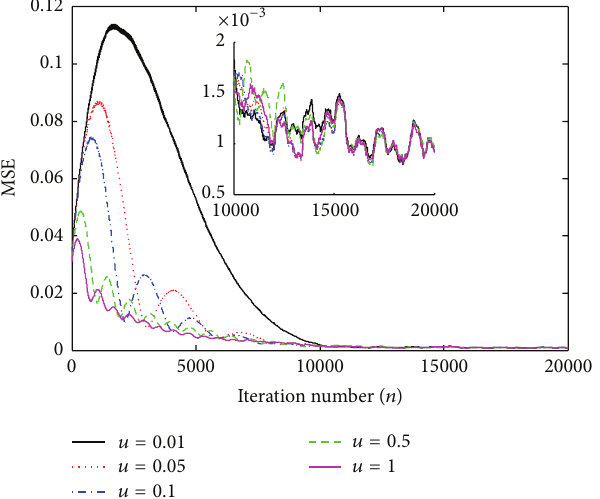
Figure 12: The MSE using the feedforward control under different step sizes.